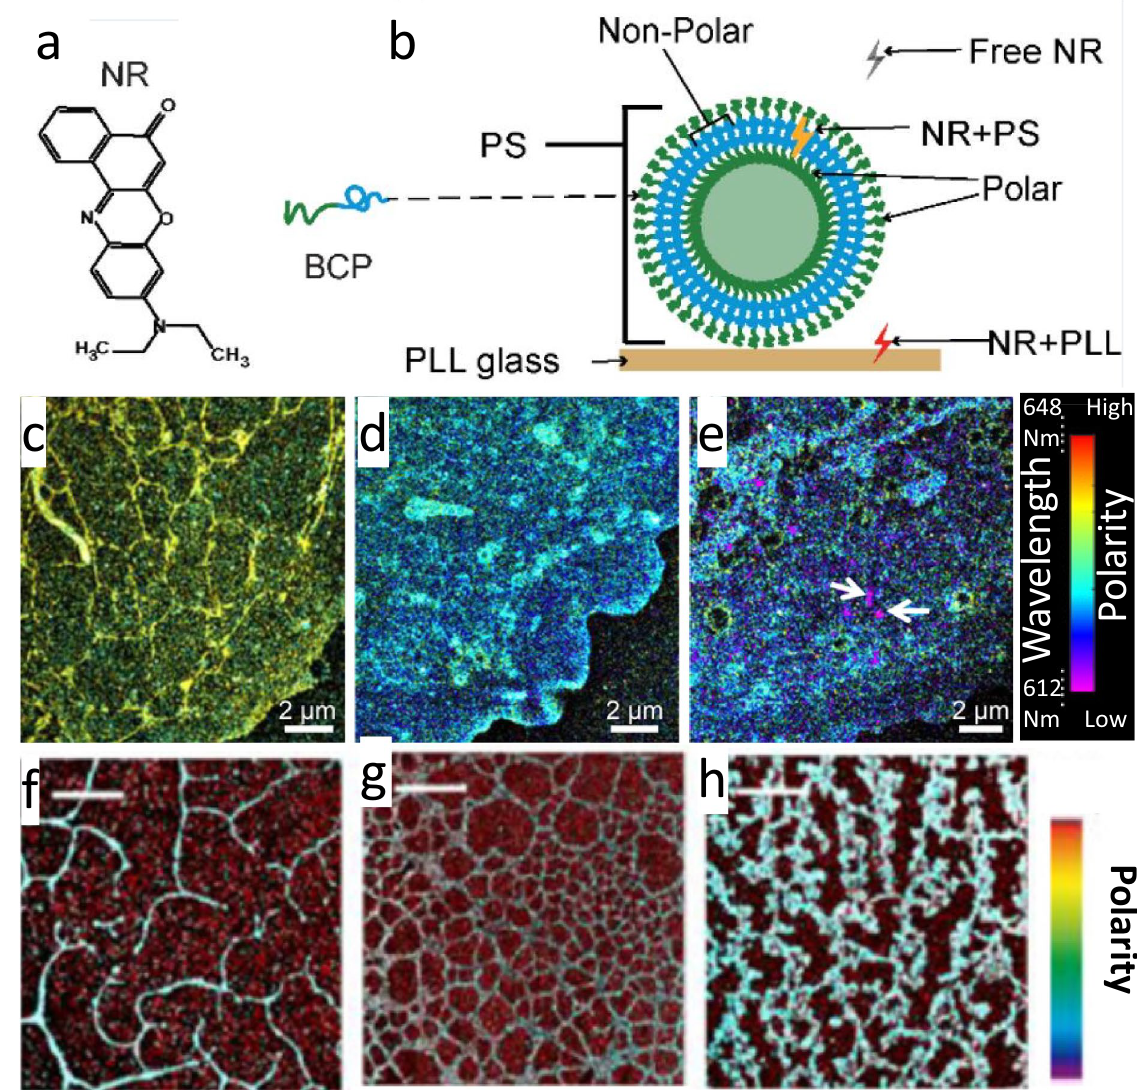
Fig. 4 a Chemical structure of NR; b Illustration of self-assembled polymersome showing that NR emits light at different wavelengths depending on whether it is free-floating, bound to the PLL-coated cover-glass, or bound to the polymersome. Reprinted with permission from [35]. Typical sSMLM images of fixed COS-7 cell membranes labeled with NR after c cholesterol depletion with MβCD, d mild cholesterol enrichment with 1 mM water-soluble cholesterol, and e cholesterol enrichment with 5 mM water-soluble cholesterol. Reprinted with permission from [28]. Typical sSMLM images of f 5:1, g 1:1, and h 1:5 mixes of PVC/PIB polymer blends. Scale bars: 5 μm (Reprinted with permission from